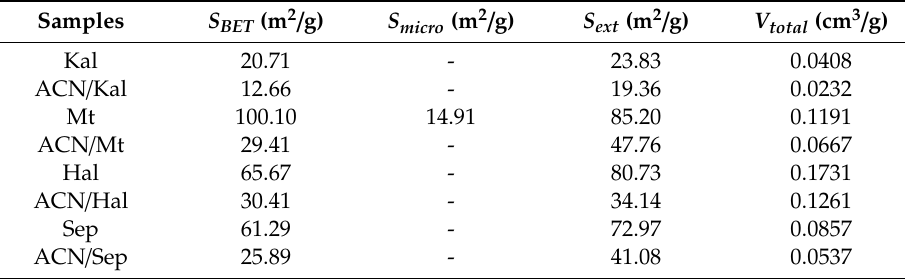
Table 1. Structural parameters of the raw clay minerals and hybrid pigments.